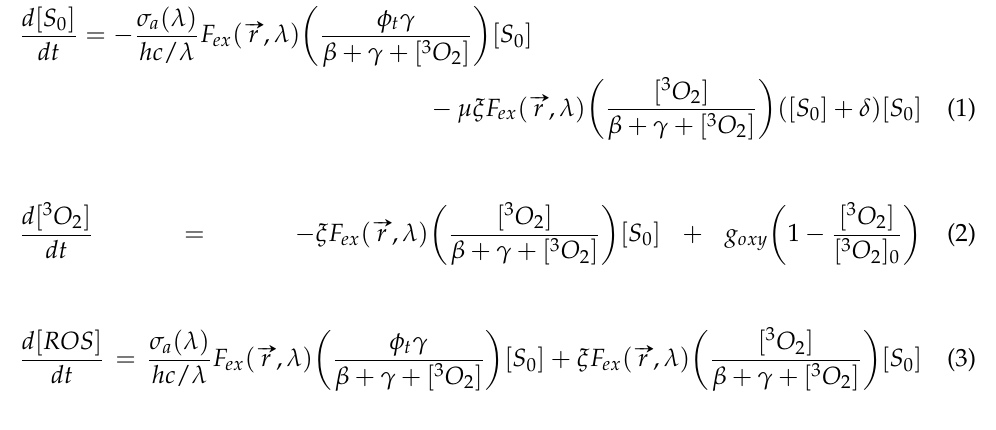
Table 2. Symbols, parameters, and definitions of Photofrin at 630 nm used in this study.